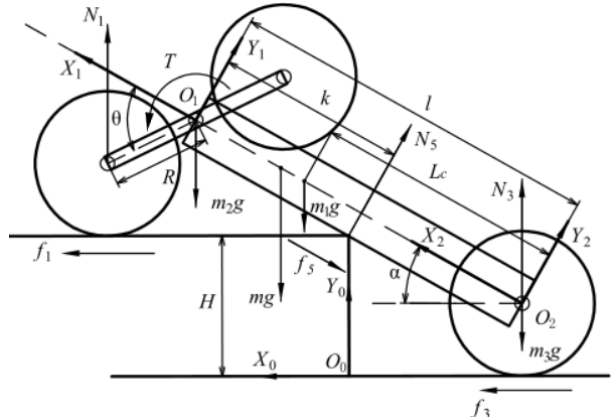
Figure 16. The static condition of the robot in the obstacle-crossing phase